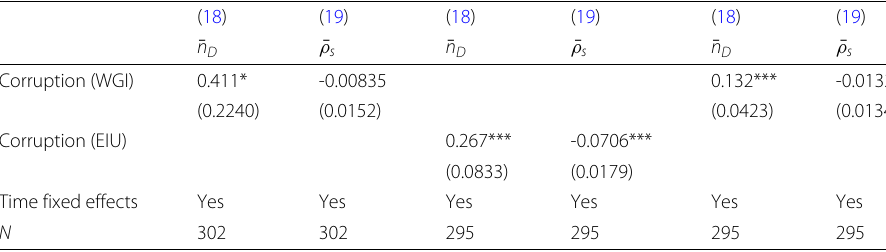
Table 5 Time fixed-effects and clustered standard